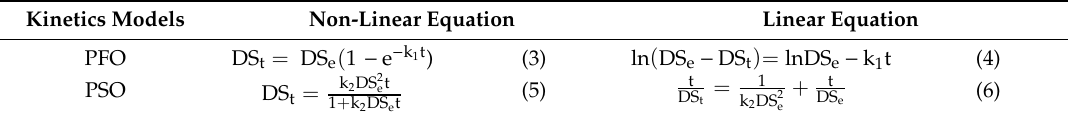
Table 5. Di ff erential and Linear Forms of Pseudo-First-Order (PFO) and Pseudo-Second-Order (PSO) Models [65].